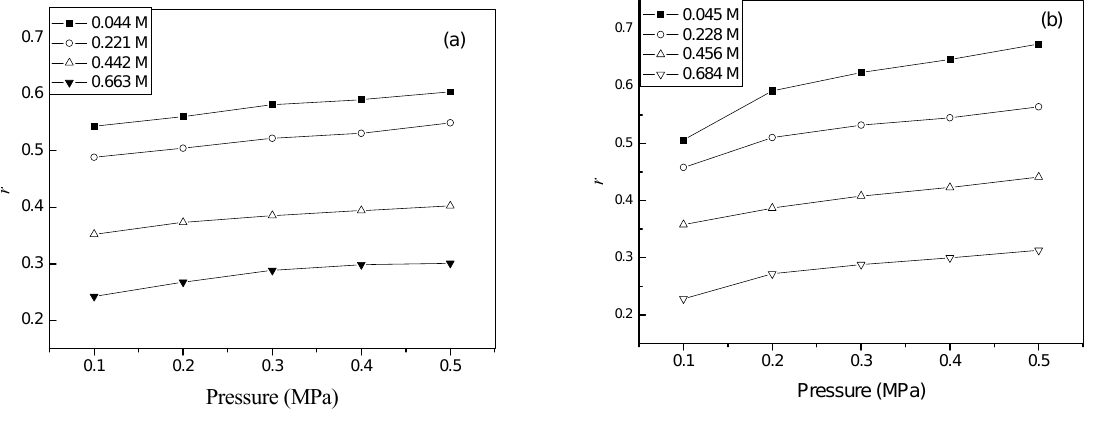
solution; (b) [Bmim]Br 4